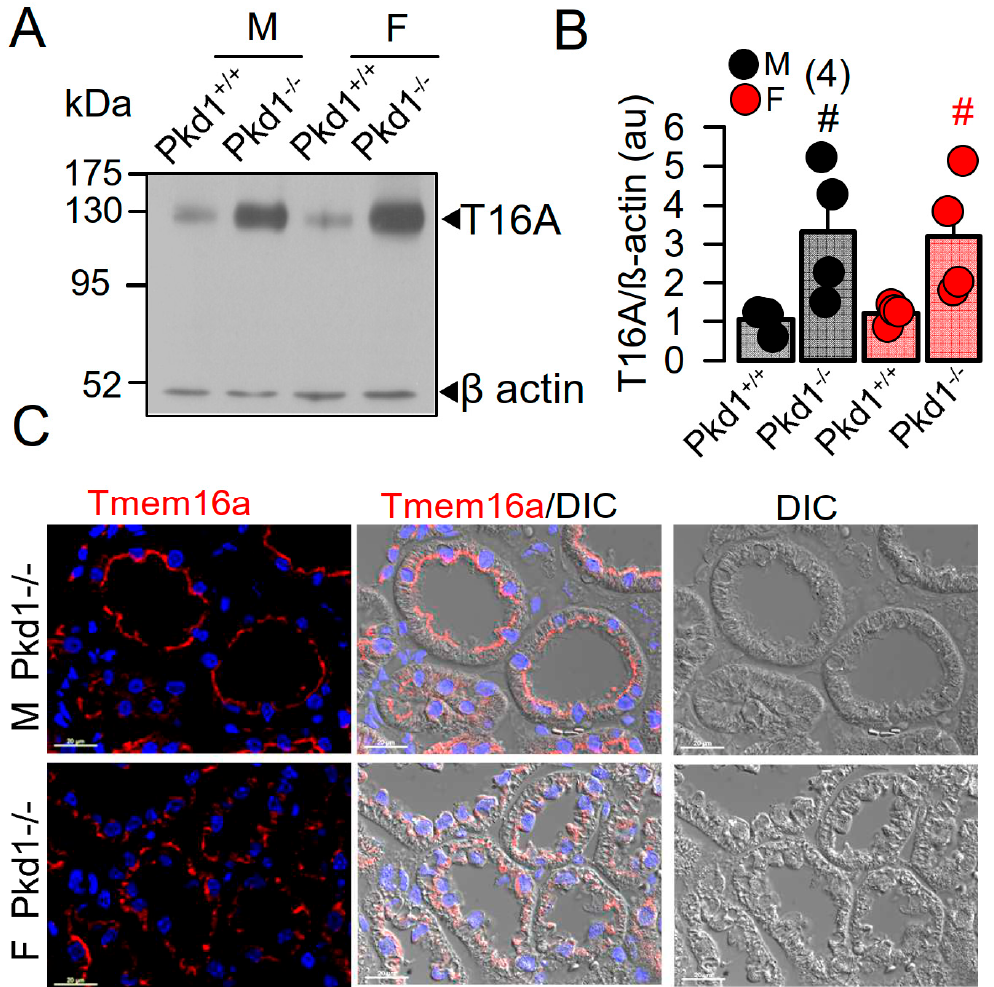
Figure 2. Expression of TMEM16A in male and female PKD1 − / − mice . ( A , B ) Western blotting of TMEM16A-expression in primary renal epithelial cells from kidneys of male and female Pkd1 +/+ and Pkd1 − / − mice. ( C ) Immunocytochemistry of Tmem16a in kidneys from male and female Pkd1 − / − mice. Bar = 20 µm. Representative images from three mice each. Mean ± SEM (number of animals in each series). # significant difference when compared to Pkd1 +/+ ( p < 0.05; unpaired t-test).